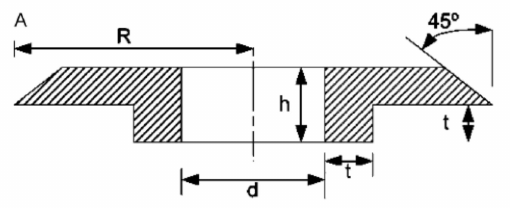
Figure 15. Optimized geometry of metal insert [18].